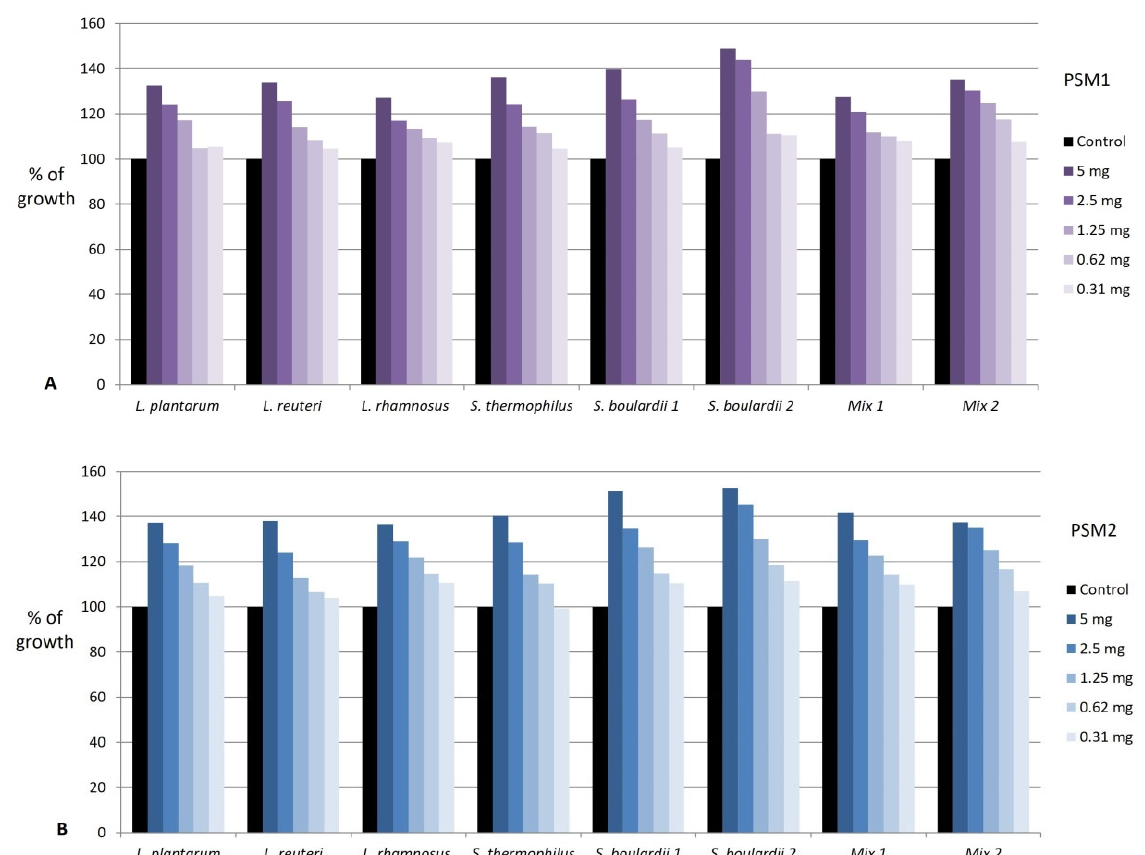
Figure 1. The prebiotic activity of blackthorn extract PSM1 ( A ) and PSM2 ( B ) on various probiotic strains of microorganisms. PSM1—methanol extract of P. spinosa fruit from the location in western Serbia; PSM2—methanol extract of P. spinosa fruit from the location in central Serbia; Results are presented as a percent of growth compared to the positive control (100% of growth). Mix 1: L. helveticus